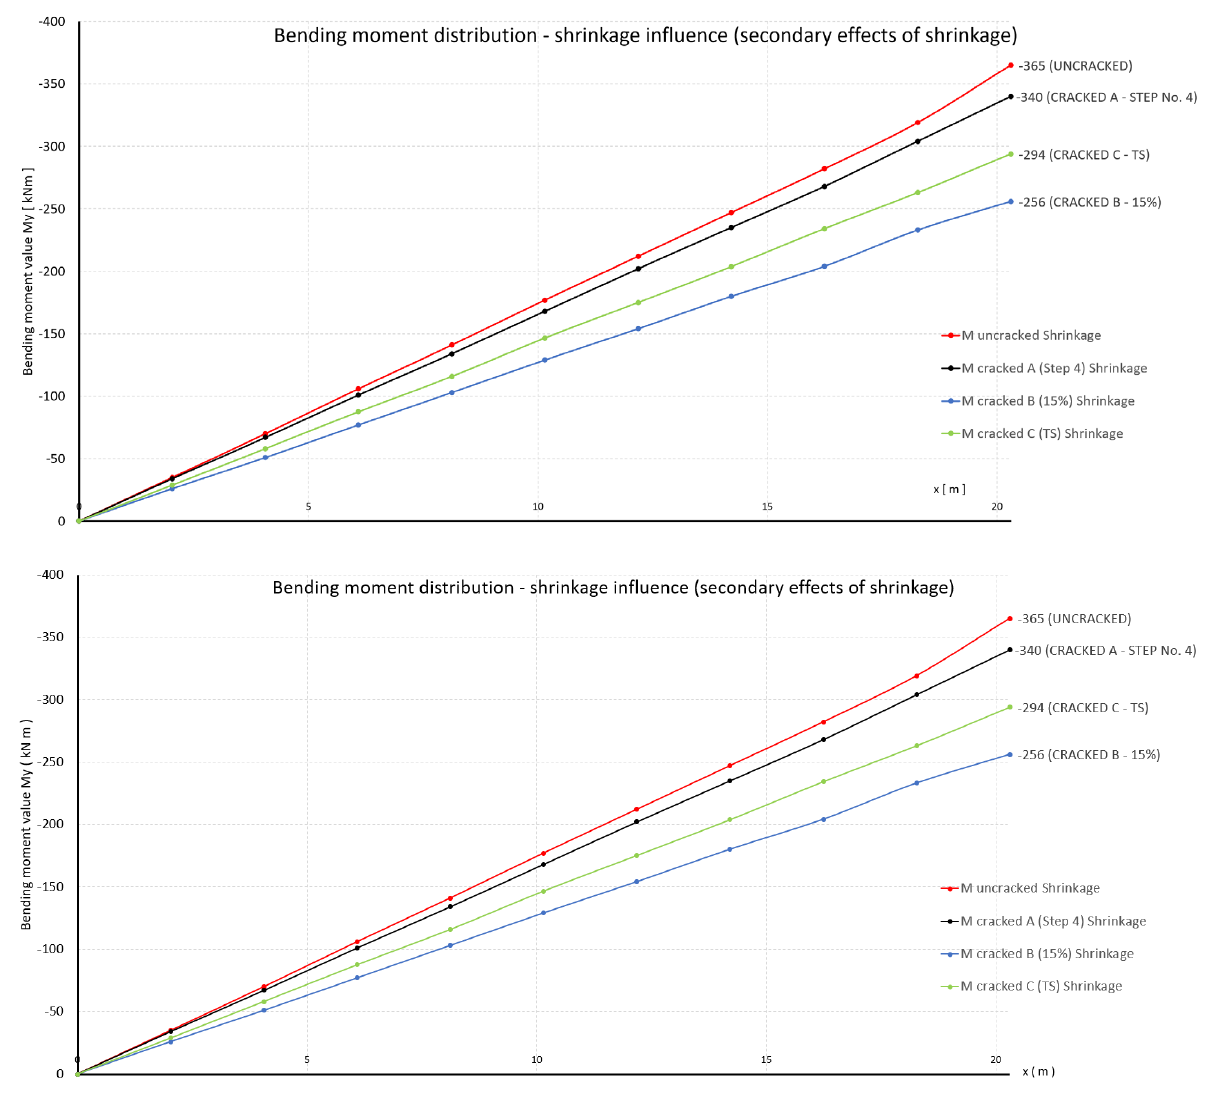
Figure 21: Bending moment distribution due to shrinkage in dependence of the assumed approach (A, B,